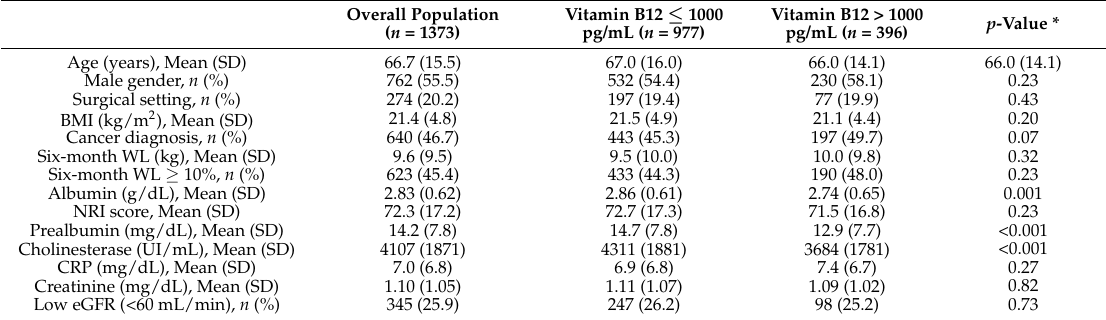
Table 1. Baseline characteristics of the study population by vitamin B12 concentrations ≤ />1000 pg/mL.